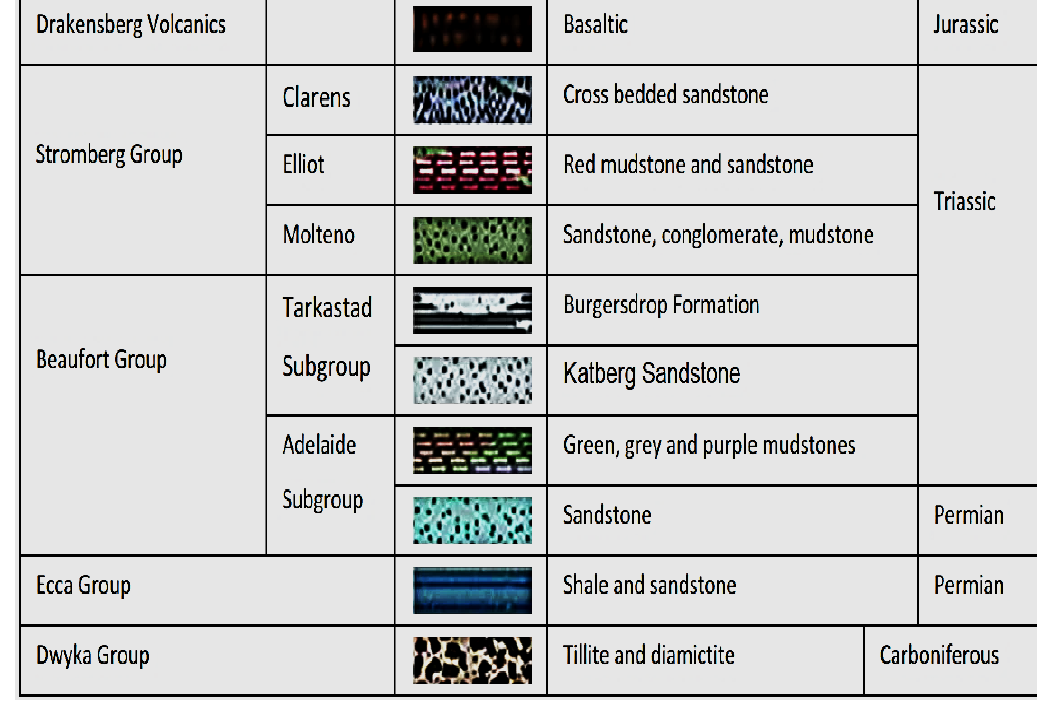
Figure 2. Schematic presentation of the Karoo Supergroup sequence [15].